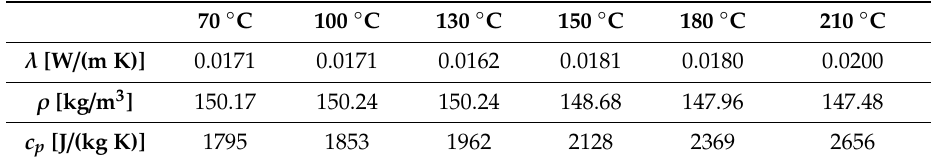
Table 2. The thermal conductivity, density, and specific heat capacity of the studied aerogel sample